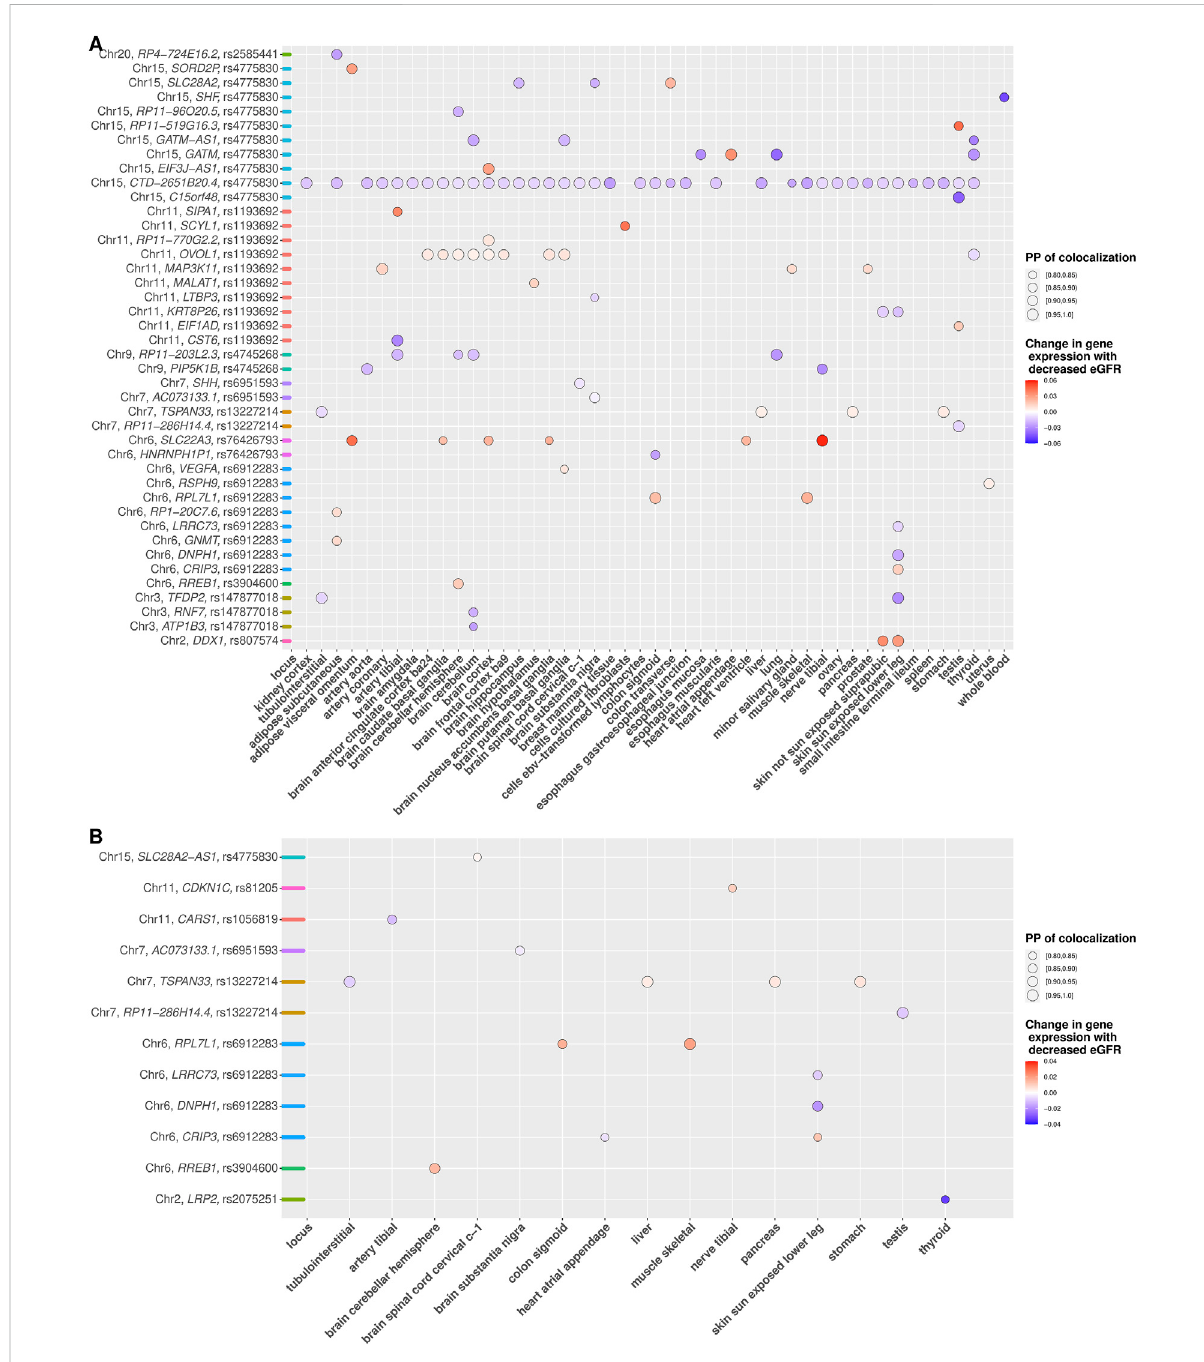
FIGURE 2 (A,B) Colocalization of eGFR association of novel independent signals with gene expression (cis eQTLs) across tissues. (A and B) depict colocalizationresultsbasedonunconditionalandconditional eGFRassociationanalyses,respectively. Genewithatleastoneposteriorprobabilityof colocalization (PP ≥ 80%) across tissues ( x -axis) is shown with the respective underlying variant and chromosome number ( y -axis). Colocalizations are illustrated as dots, where dot size corresponds to the PP and are colored according to the predicted change in gene expression relative to the lower eGFR. Color coding on the y -axis re fl ects the